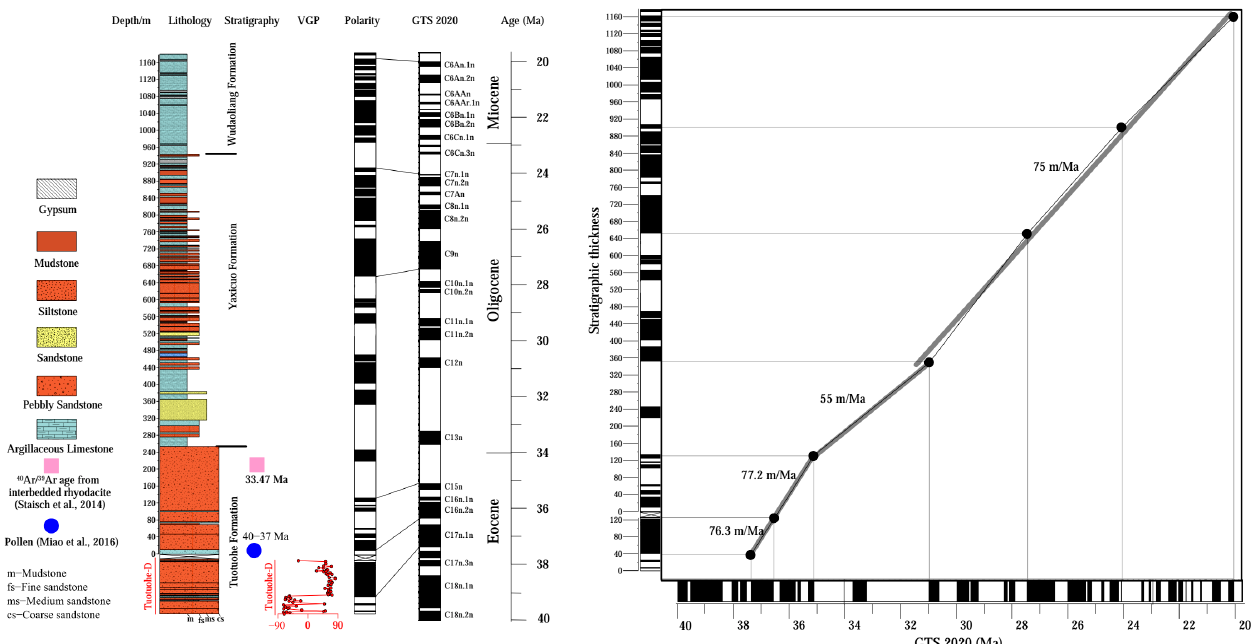
Figure 8. Magnetostratigraphic results for the TTH-D section and their correlation with the GTS [55] and the sedimentation rate. This correlation is constrained with the additional part of the TTH section [28].